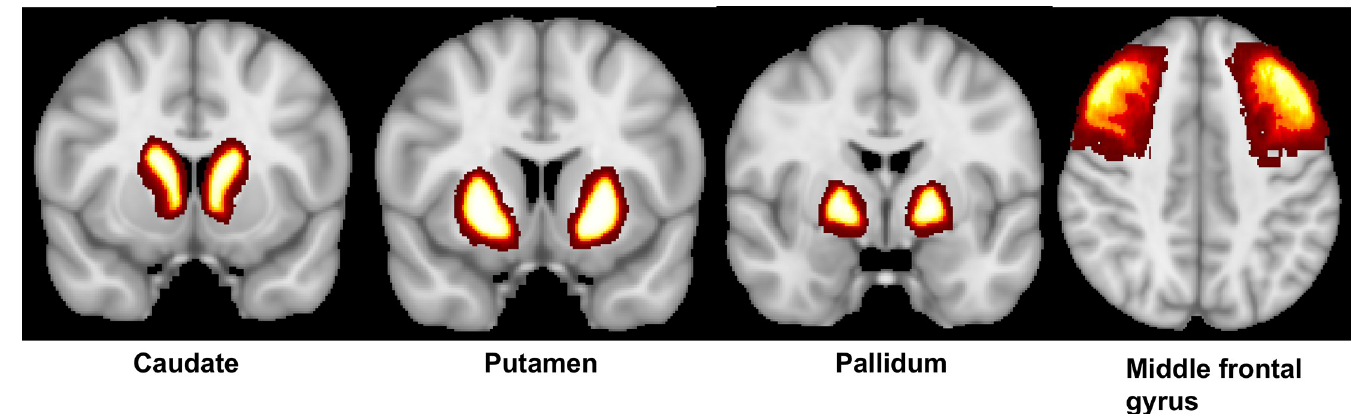
Fig 1. Seeds used in seed-based correlation analyses. The following 7 seeds were selected from the Harvard-Oxford subcortical (seeds 1–6) and cortical (seed 7) atlases: 1) Left Caudate; 2) Right Caudate; 3) Left Putamen; 4) Right Putamen; 5) Left Pallidum; 6) Right Pallidum; 7) Bilateral Middle Frontal Gyrus.